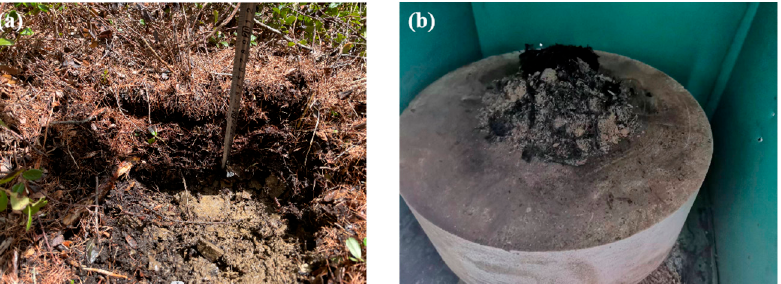
Figure 2. Soil sample before and after the smouldering combustion experiment: ( a ) before combustion; ( b ) after combustion.